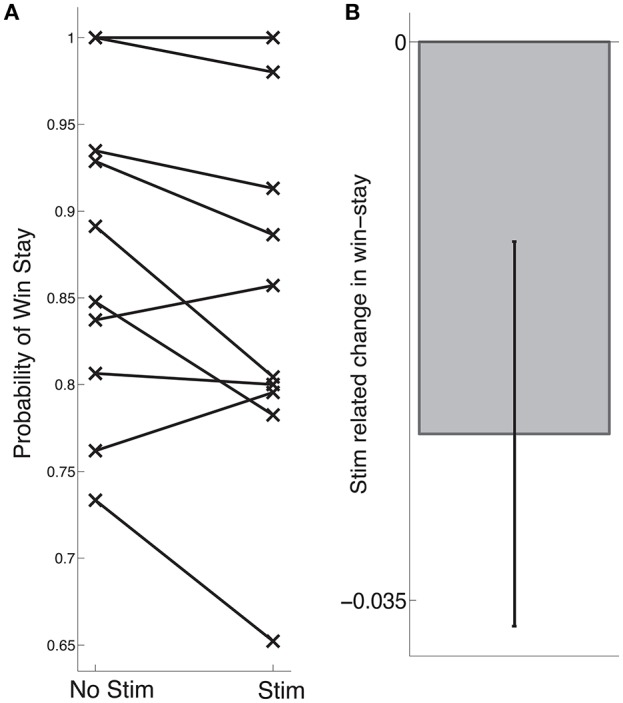
Stimulation-related change in learning. (A) Each subjects' probability of win stay during stage 2 is indicated by an “x,” following control trials on the left and following stimulation trials on the right. (B) Across subjects, we observed a trend toward an stimulation-related decrease in learning (p = 0.068). Error bars indicate standard error of mean (s.e.m) across subjects; see main text for statistics.